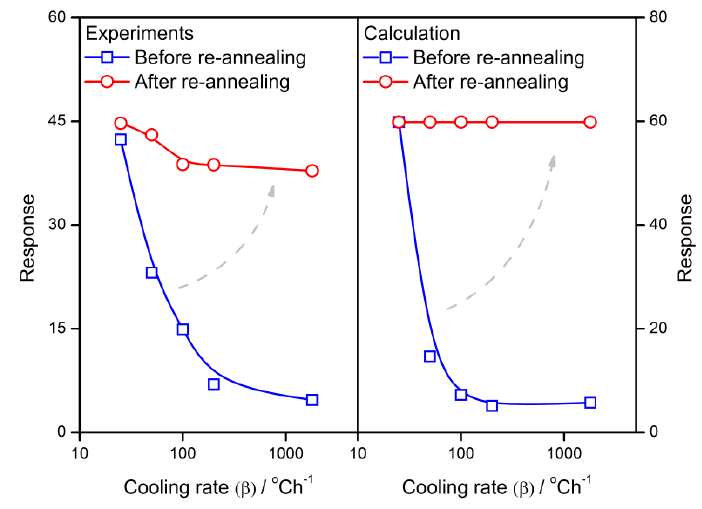
Figure 18. The re-annealing effect of experimental and calculated response of semiconductor gas sensors.